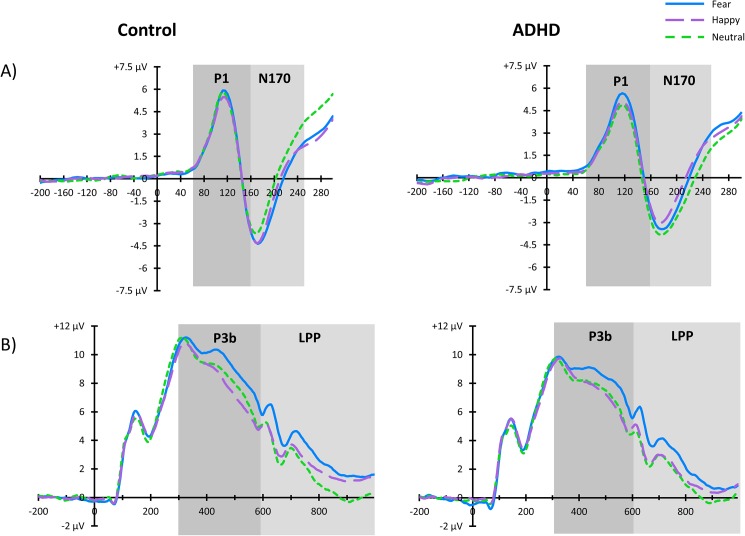
Illustration of the grand average ERP waveforms for the A) N170 at electrode site P7 and P8 collapsed, and B) P3b and LPP at electrode sites P3, P4, and Pz collapsed.